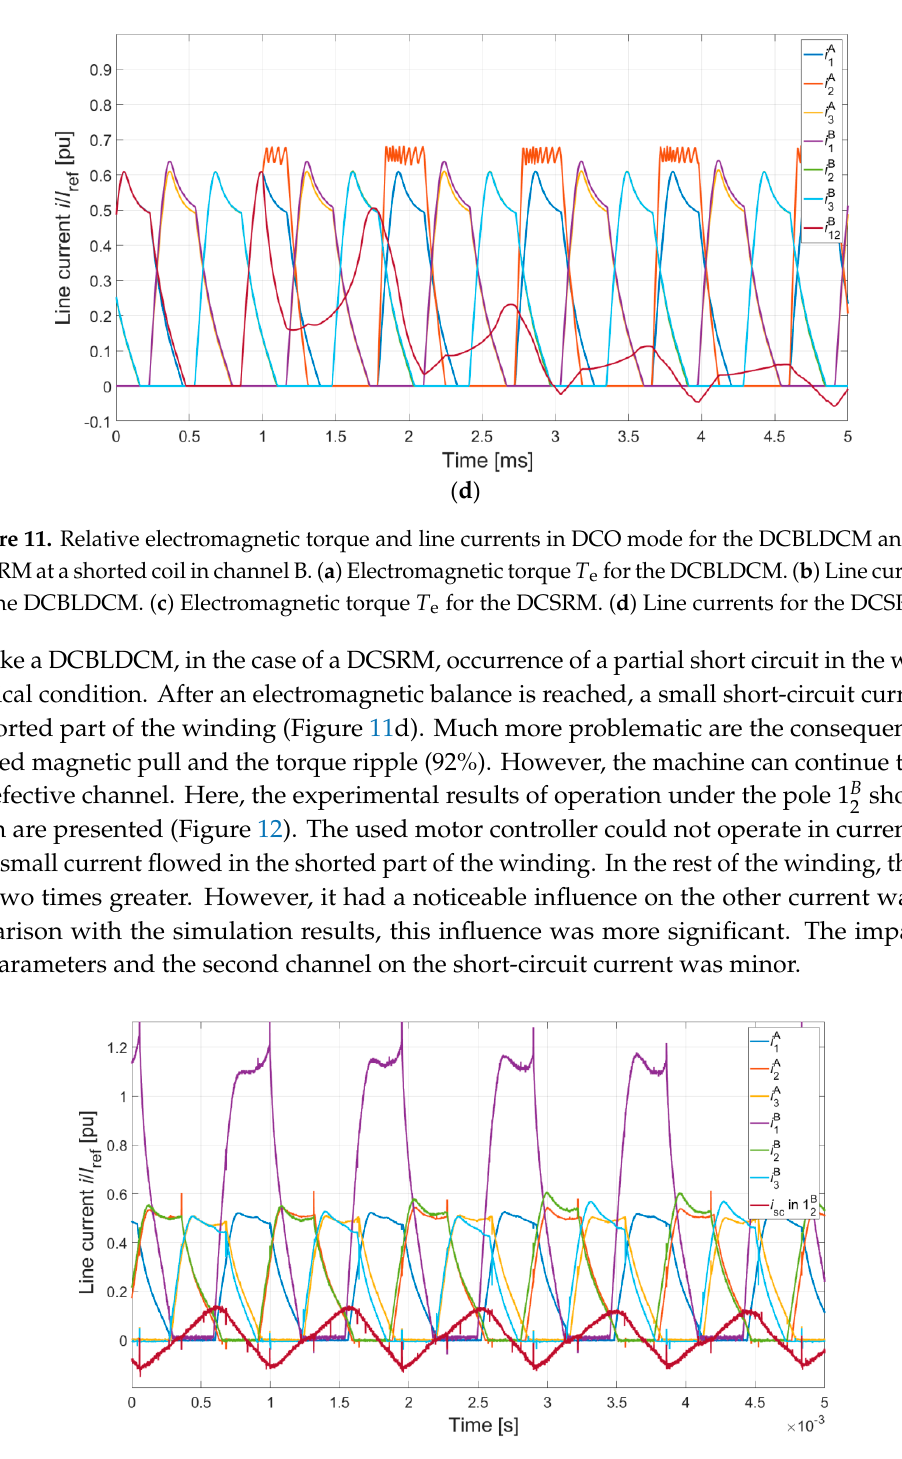
Figure 12. Line currents in DCO mode for the DCSRM at a shorted coil in channel B—laboratory test.